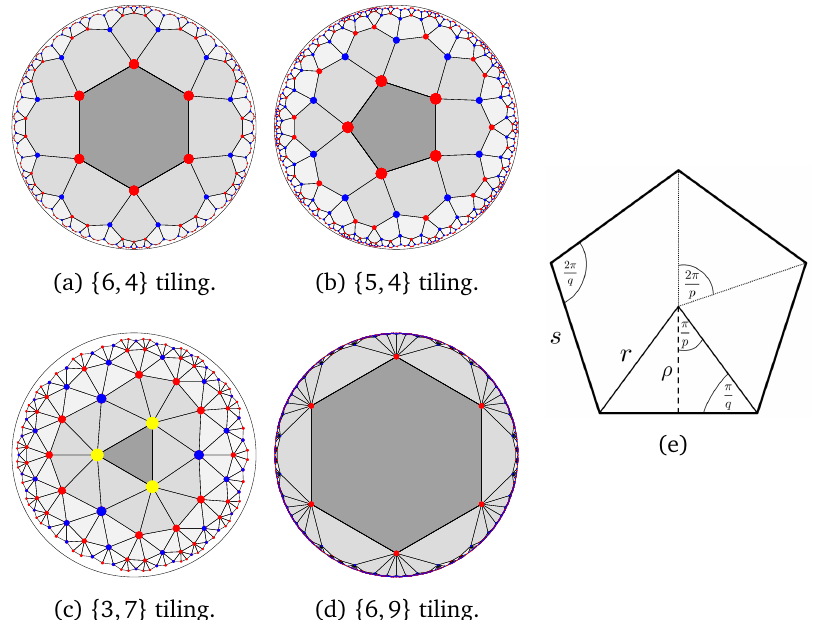
Figure 2: a)-d): Examples of { p , q } regular hyperbolic tilings for all parity combi- nations of the Schläfli parameters. The red, blue and yellow dots denote vertices of type a, b and (cid:254) , respectively, according to the inflation rules introduced in Sec. 2.2. The different shades of gray depict successive layers of this inflation procedure. e) Characteristic lengths and angles of a single polygon in { 5, q } tiling, as defined in (7) and (8). Due to the intrinsic length scale given by the curvature radius, these lengths are fixed as a function of p and q and cannot be